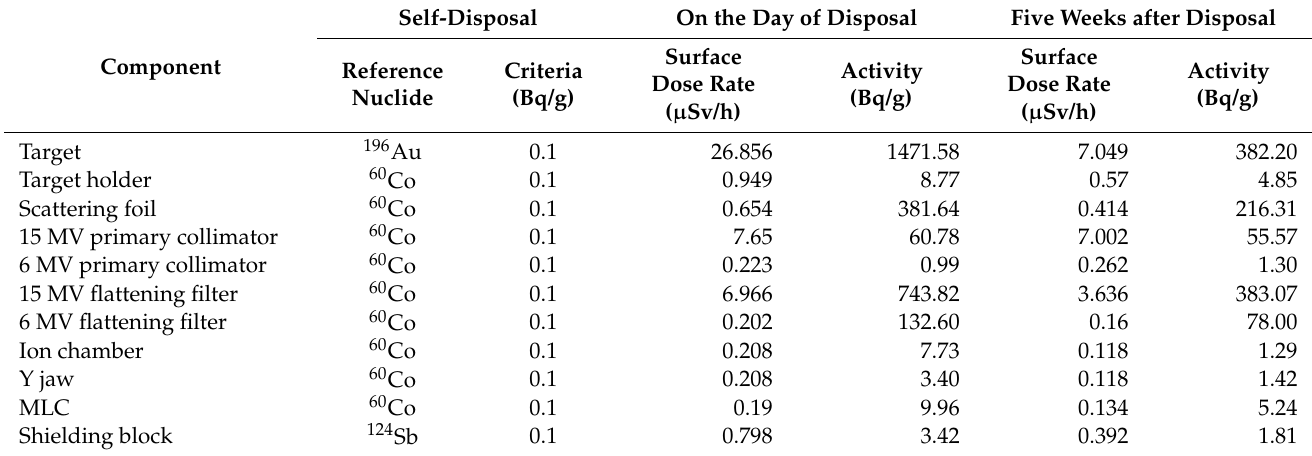
Table 6. Radioactivity calculated using the Japanese radioactive waste management